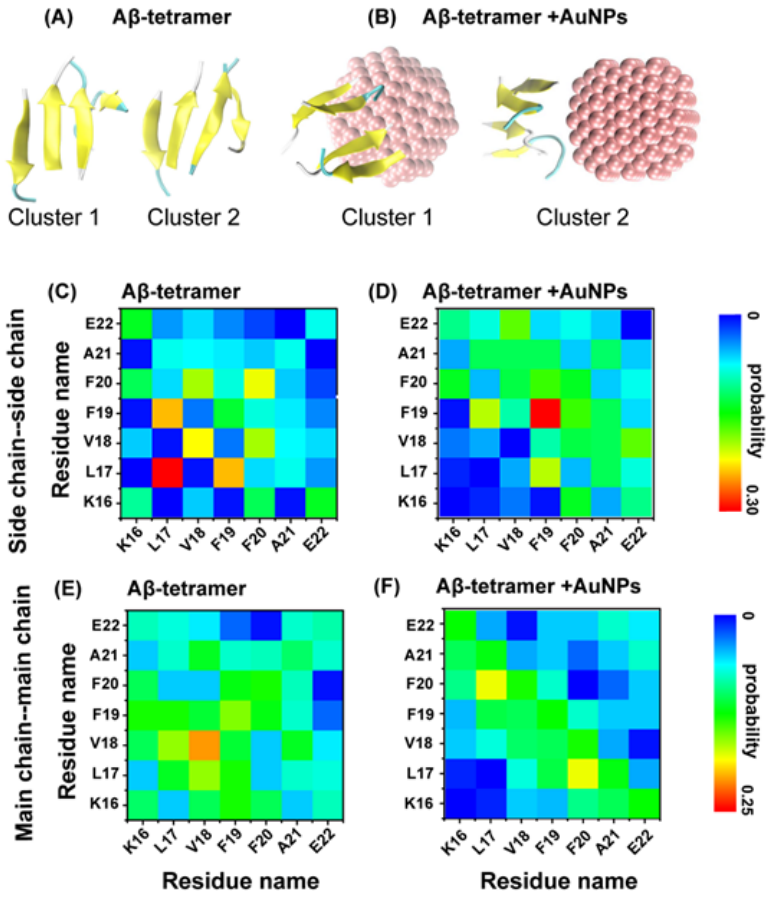
Figure 3. Representative conformations of the top two most-populated clusters for the A β tetramer in the absence ( A ) and presence ( B ) of AuNPs. Side-chain-side-chain (SC-SC) and main-chain-main-chain (MC-MC) contact probability maps for Aβ tetramer in the absence ( C , E ) and presence ( D , F ) of AuNPs. The Aβ tetramer is shown in new cartoon representation. The peptides are colored in yellow. The AuNPs are in vdW representation and colored in pink.